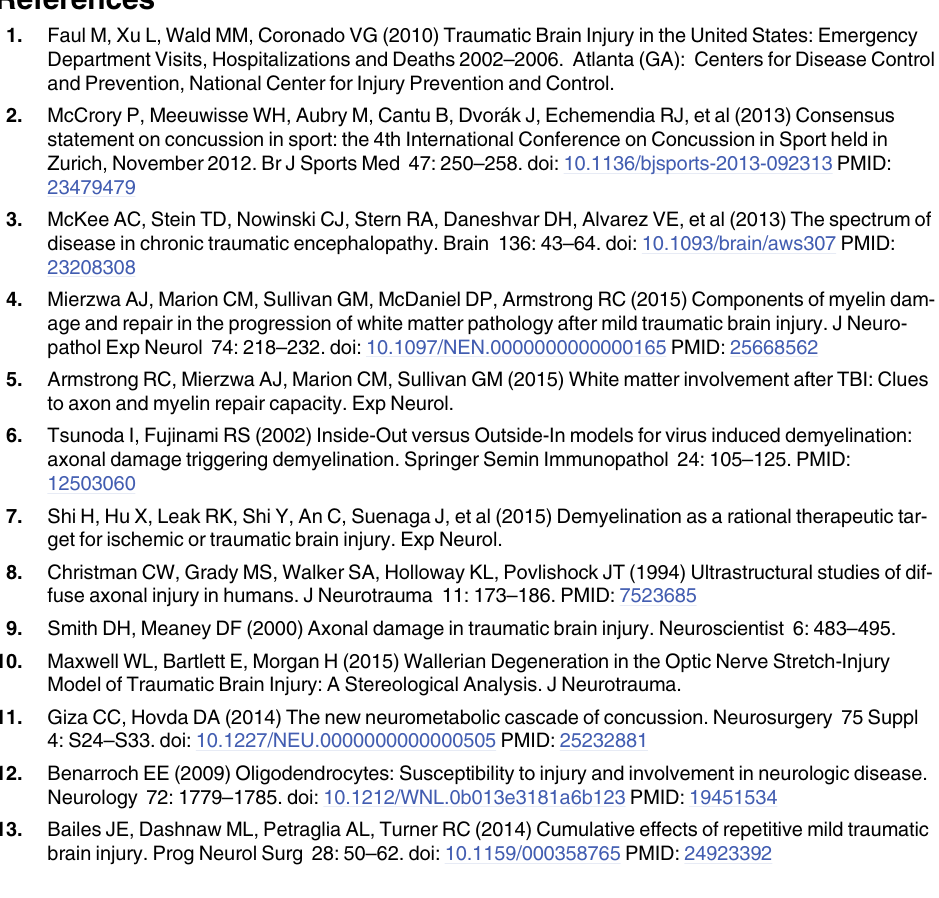
S1 Table. Raw myelin water fraction values across concussed athletes for each scan. Each column represents raw myelin water fraction data from a given subject (S##) at baseline